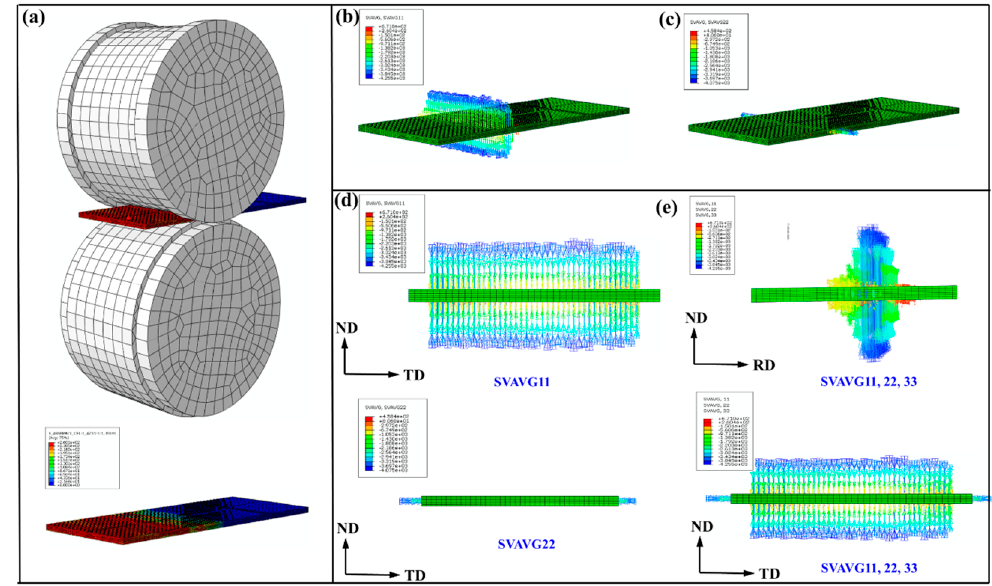
Figure 11. ( a ) Models and ( b – e ) the average stress per unit volume of RR50%.